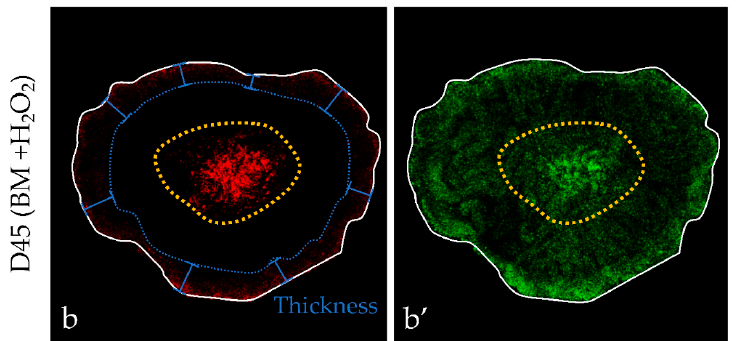
Figure 2. ROS detection in frozen-thawed and living testicular explants using the CellROX kit probes at D45 of culture using ex vivo imaging by confocal macroscopy. To control the specificity of the signal, frozen-thawed (F-T) testicular explants were cultured with basal medium (BM) ( a,a’ ) or incubated with BM supplemented with 200 µM H 2 O 2 ( b,b’ ) overnight as positive controls. Fluorescent signal intensity appeared stronger with H 2 O 2 , either for CellROX orange reagent or green reagent, when compared with BM control. The solid line delineates the outline of the testicular fragment. Necrotic central area is delimited with yellow dotted circle and was not taken into consideration in the peripheral ROS-positive thickness region evaluation (dotted blue line). Photomicrographs were captured with a 1.1 optical zoom at a ×4.9 total magnification. The scale bar represents 1 mm. BM, basal medium; D, day; H 2 O 2 , hydrogen peroxide; ROS, reactive oxygen species.